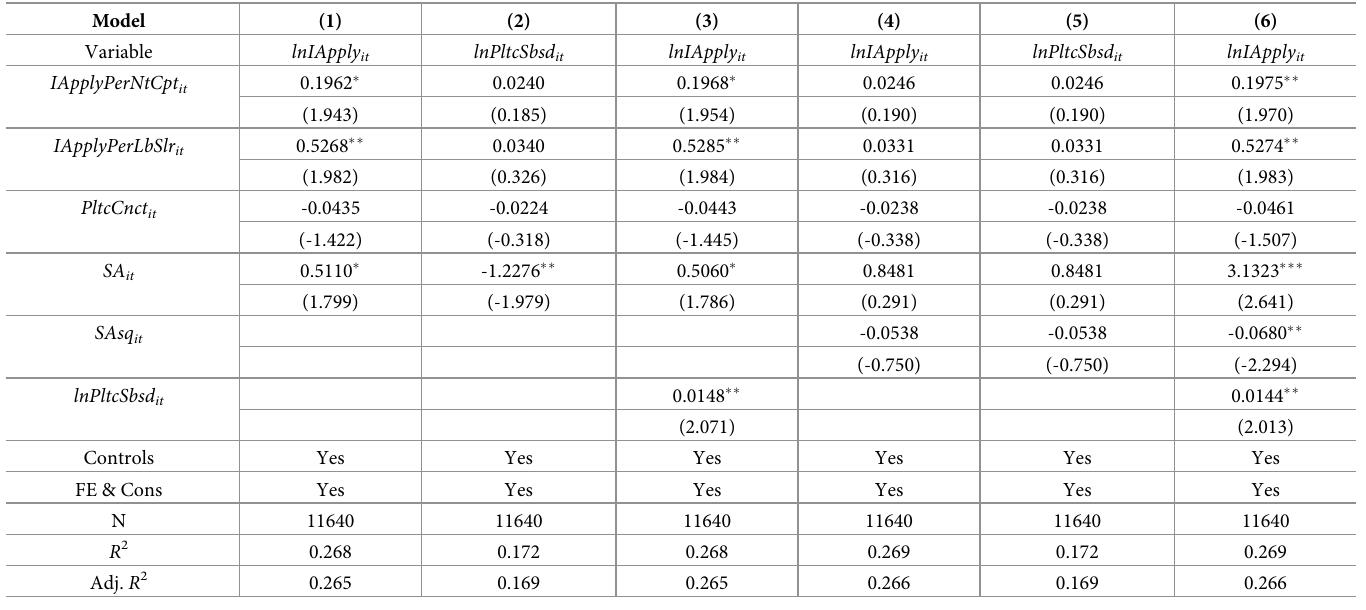
Table 5. Subsample results of exploratory innovation